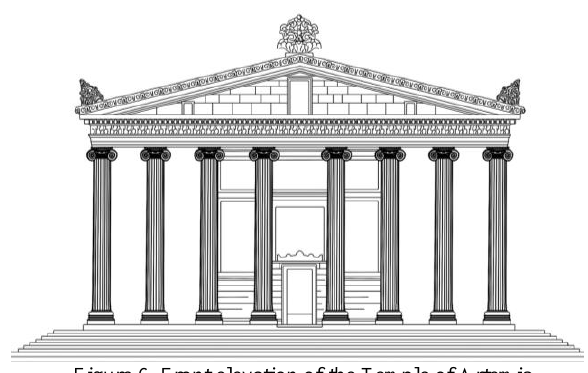
Figure 6. Front elevation of the Temple of Artemis Leukophryne at Magnesia (Adaption after Humann)